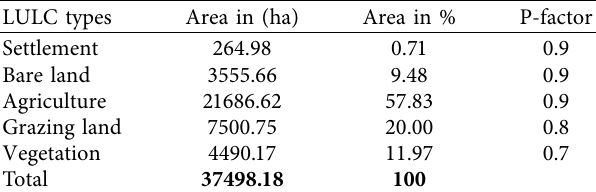
Figure 6: Map of (a) land use land cover types and (b) cover factor (C-factor). Table 4: Management practice (P) factor